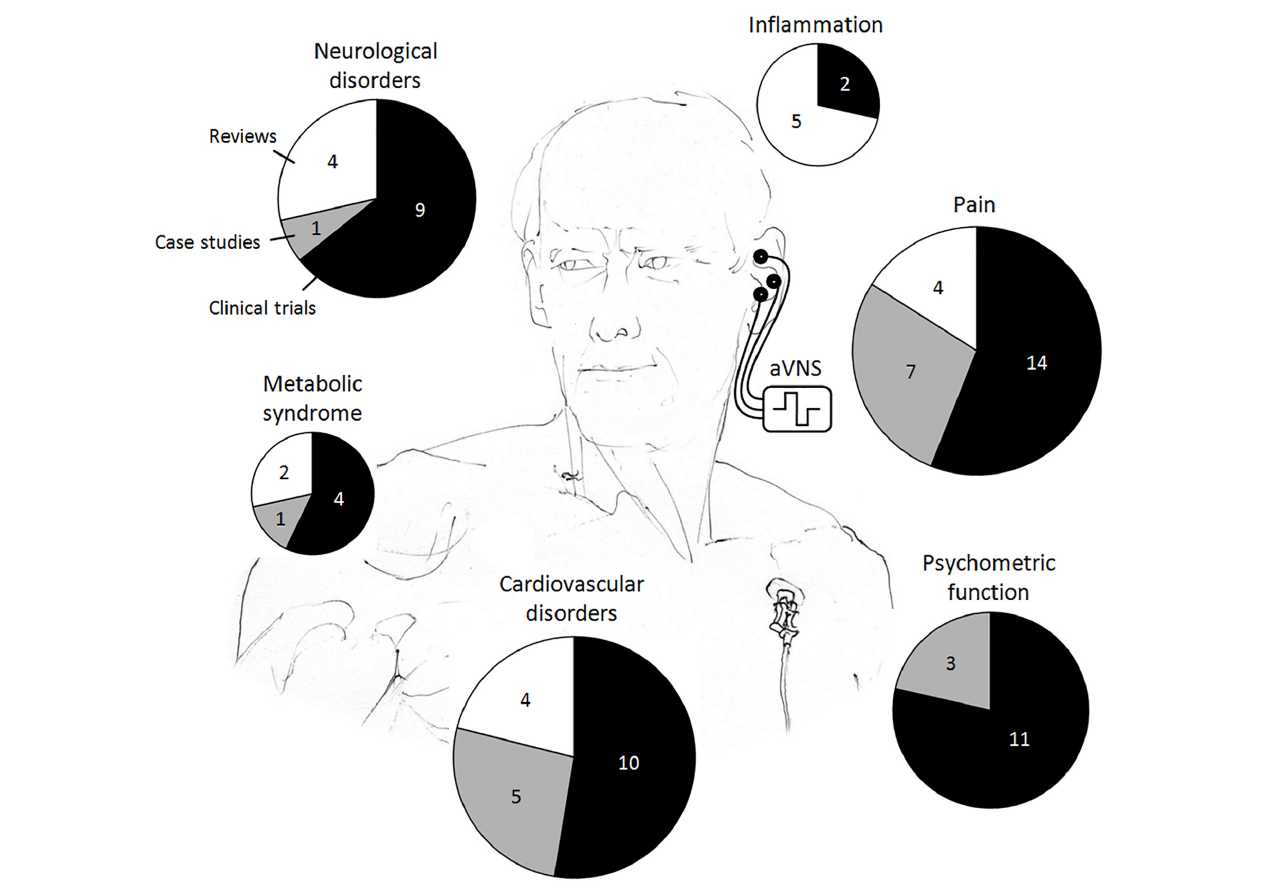
FIGURE 3 | Reported clinical applications of the auricular vagus nerve stimulation (aVNS) in humans. The total area of the pie chart indicates the total number of publications reviewed, whereas individual pieces refer to the respective numbers of clinical trials, case studies, and